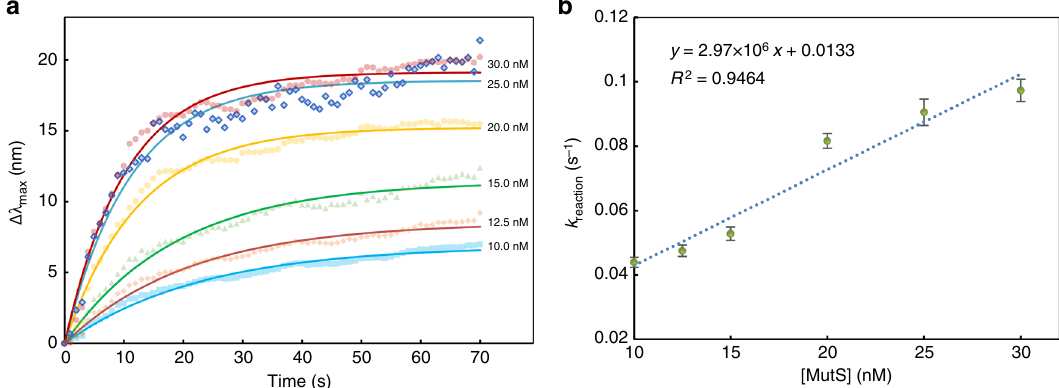
Fig. 4 Reliability of sensing. a Real-time monitoring of MutS at various concentrations binding to GT-mutant DNA. b Dependence of rate constant on MutS concentration. Error bars represent mean ± S.E.M. All experiments were performed in triplicate. Source data are provided as a Source Data fi